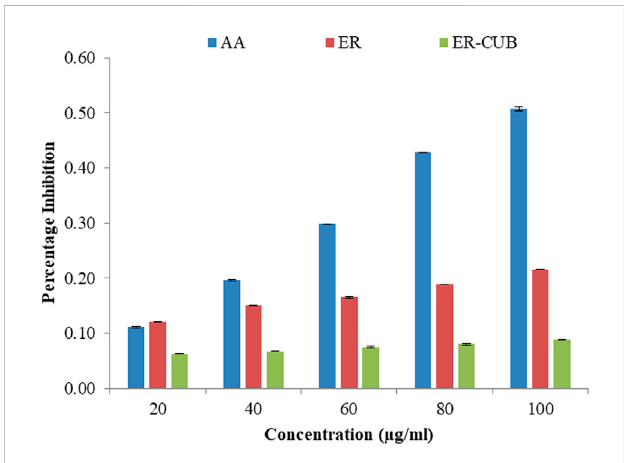
FIGURE 11 Showing the reducing potential of ER and ER-CUB in ferric reducing power